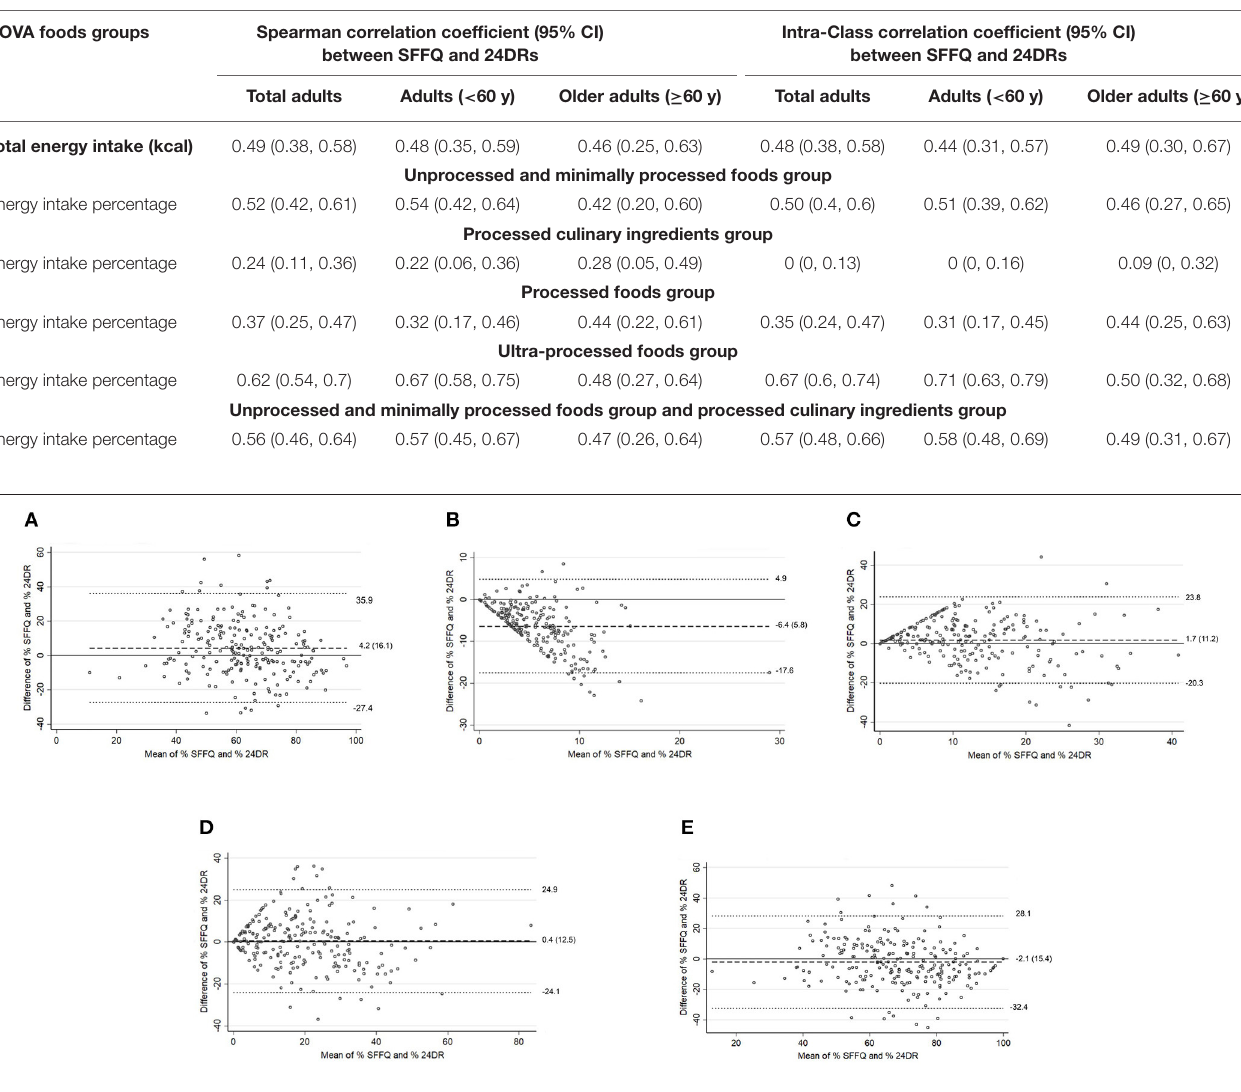
FIGURE 1 | Total adults. Bland–Altman plots for % energy intake between the SFFQ and 24DRs: (A) Unprocessed and minimally processed foods group. (B) Processed culinary ingredients group. (C) Processed foods group. (D) Ultra-processed foods group. (E) Unprocessed and minimally processed foods group and processed culinary ingredients group. Dotted lines represent 95% limits of agreement. Dashed line represents difference of